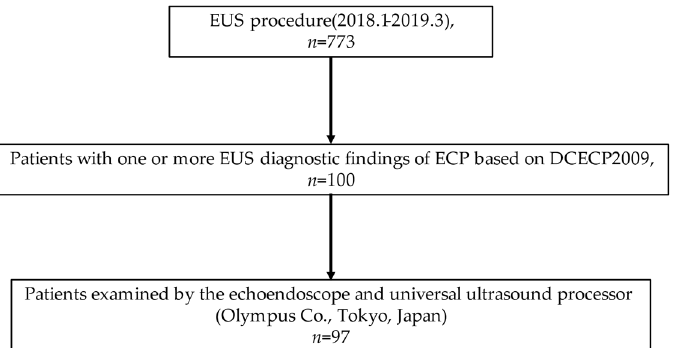
Figure 1. Flow diagram of this study.EUS, endoscopic ultrasound; ECP, early chronic